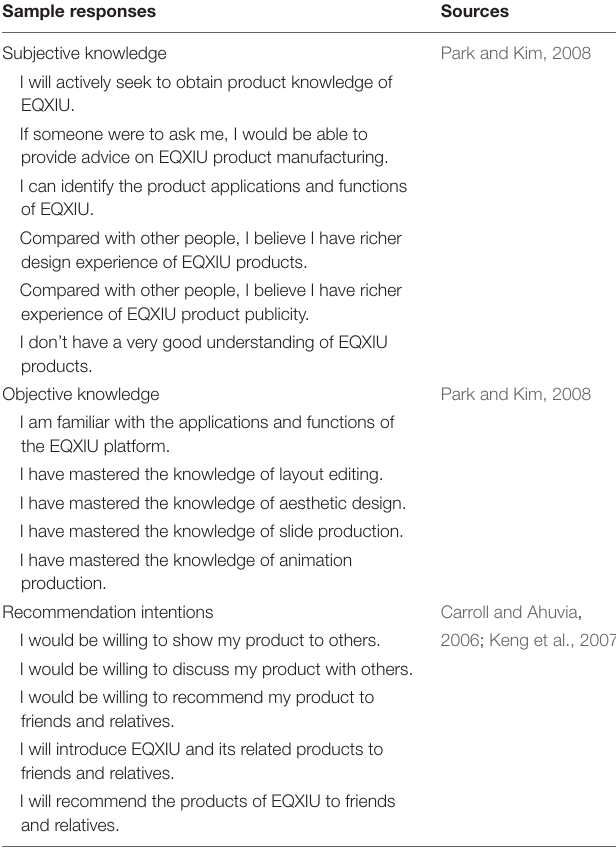
TABLE 4 | Questions to assess customer’s knowledge and recommendation